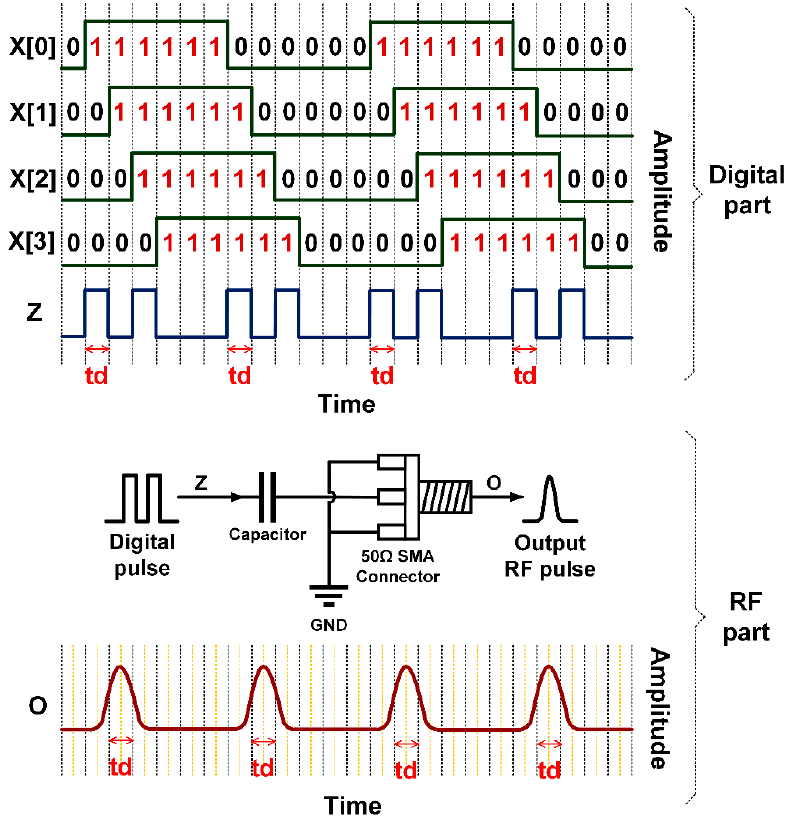
Figure 6. Application of XOR to four staggered delay paths (X[0], X[1], X[2], and X[3]) for four narrow active pulses per cycle where z is the output of edge combiner.